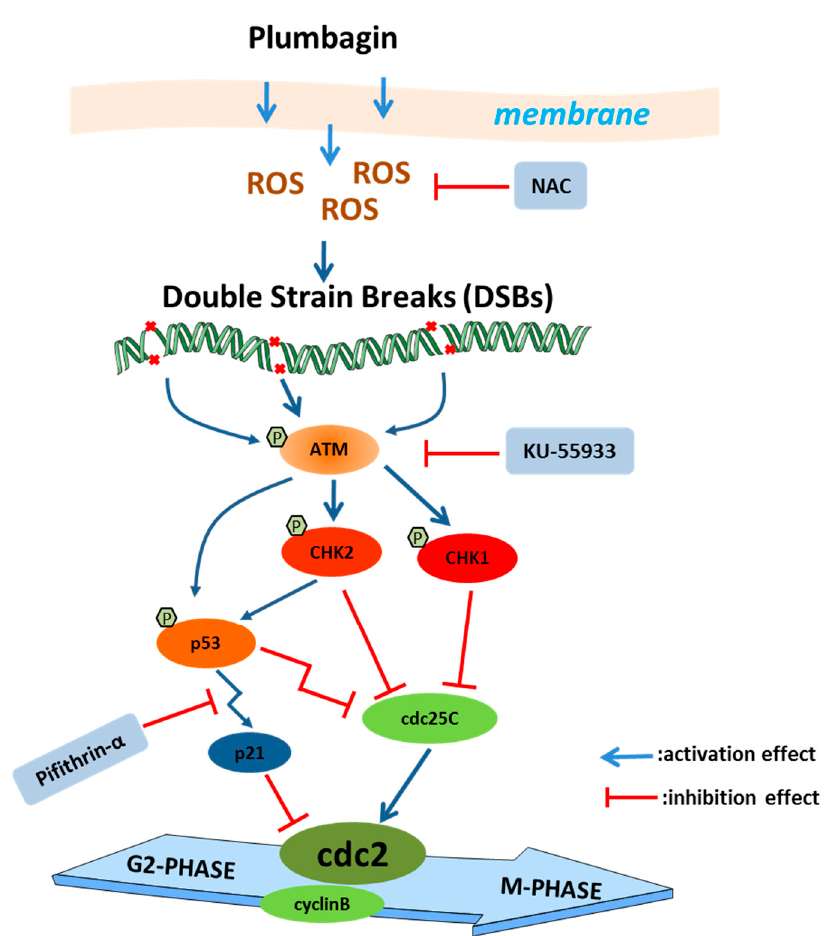
Figure 11. Presumed molecular mechanism of plumbagin-induced G2/M cell cycle arrest.